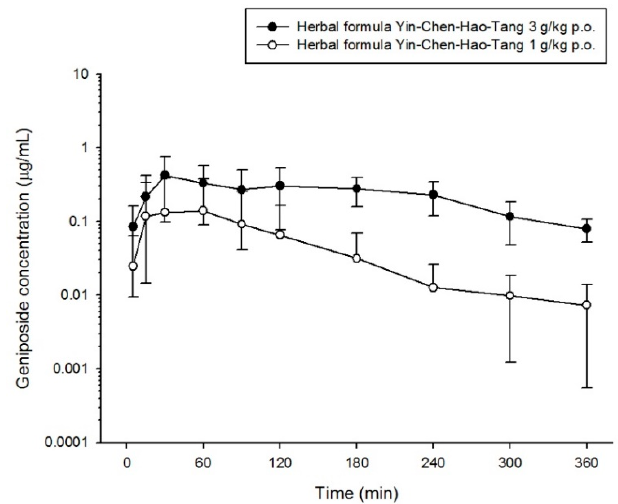
Figure 4. Concentration-time profile of geniposide in rat plasma following oral administration of different dose of herbal formula (1 g/kg p.o. or 3 g/kg p.o. Yin-Chen-Hao-Tang).